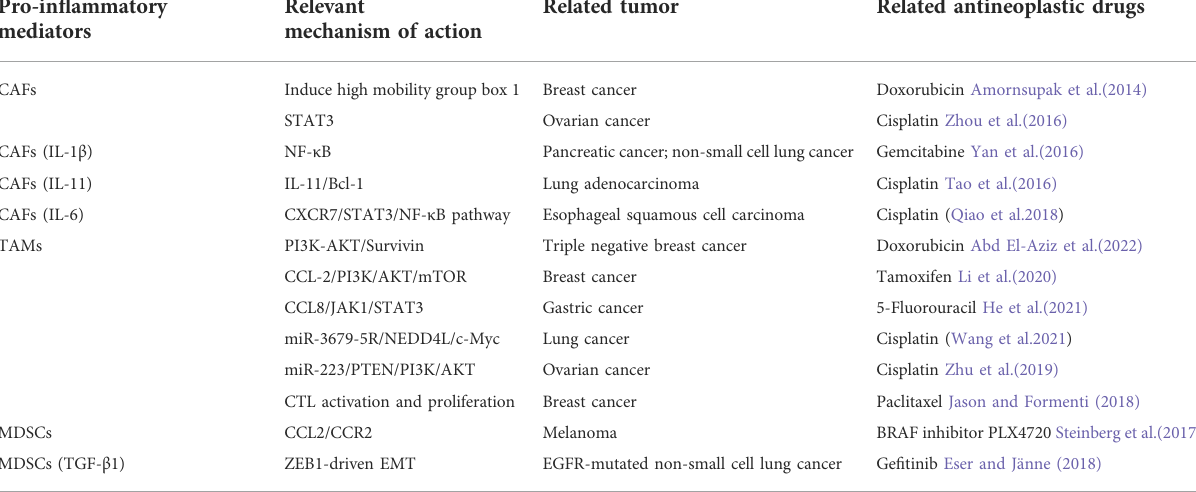
TABLE 2 Pro-in fl ammatory mediators causing tumor resistance in the tumor microenvironment